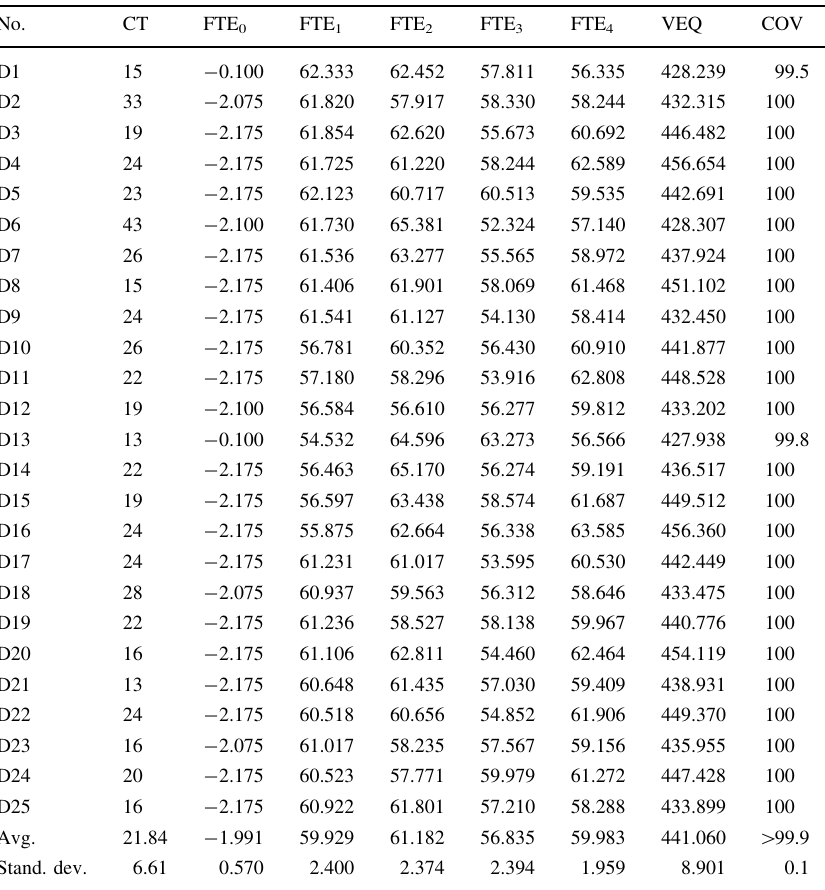
Table 3 Scenario analysis 2—demand